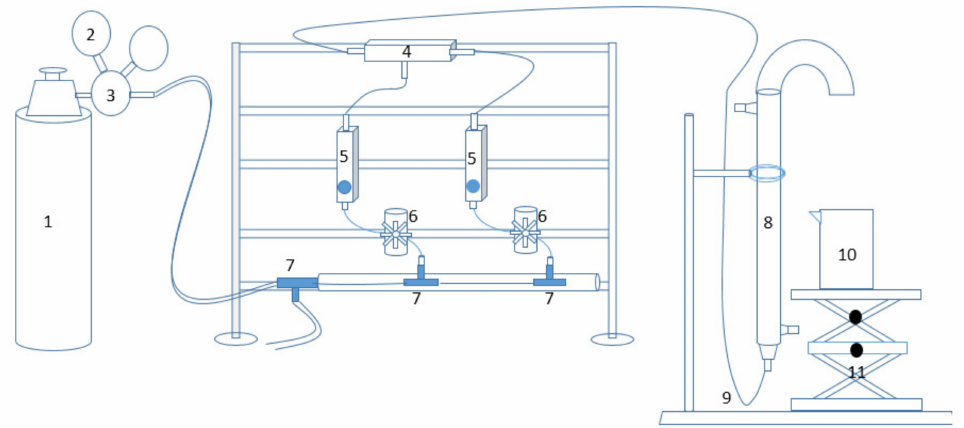
Figure 2. Schematic diagram of the foam separation device. 1, compressed air cylinder; 2, gas cylinder pressure gauge; 3, cylinder reduction valve; 4, gas mixer; 5, rotameter; 6, branch control valve; 7, main control valve; 8, foam separation column; 9, iron stand; 10, sample collection beaker; 11,